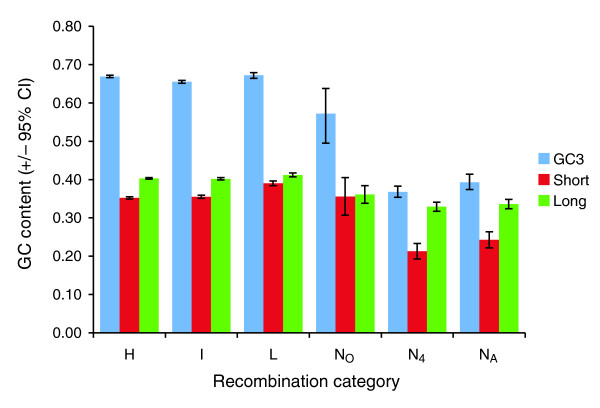
GC content of the third position of codons, short introns, and long introns for each recombination region. GC content at the third position of codons (GC3), short introns (≤80 base pairs [bp]) and long introns (>80 bp) for regions of high, intermediate and low frequency of crossing over and regions of no crossing over. Values reported are means per site for all introns from D. melanogaster and D. yakuba combined; error bars indicate 95% confidence interval (CI) obtained by bootstrapping by gene/intron.